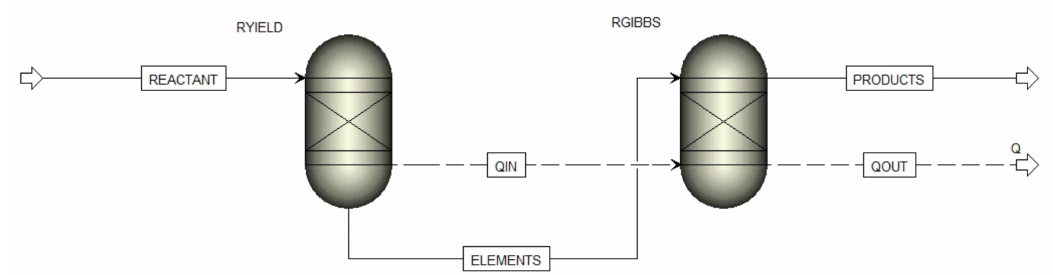
Figure 1. Aspen Plus scheme used to model pyrolysis.